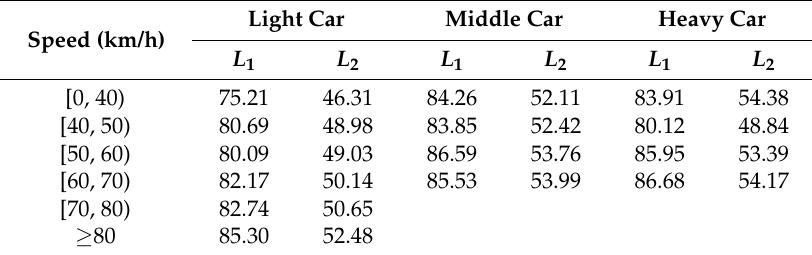
Table 2. Noise levels computed in the insertion loss experiment